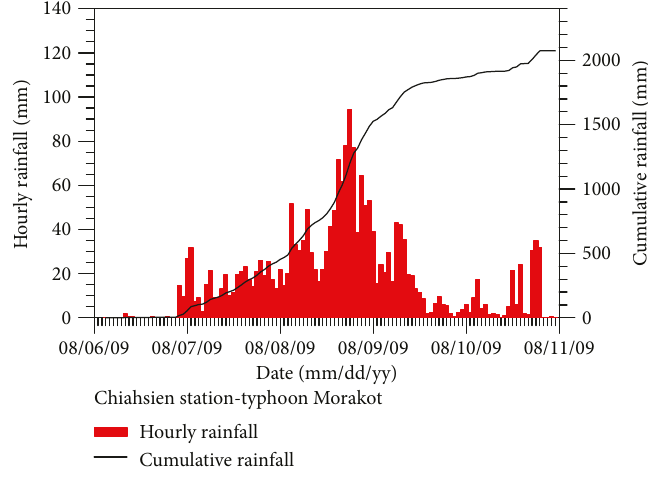
Figure 4: Rainfall data at the Chiahsien